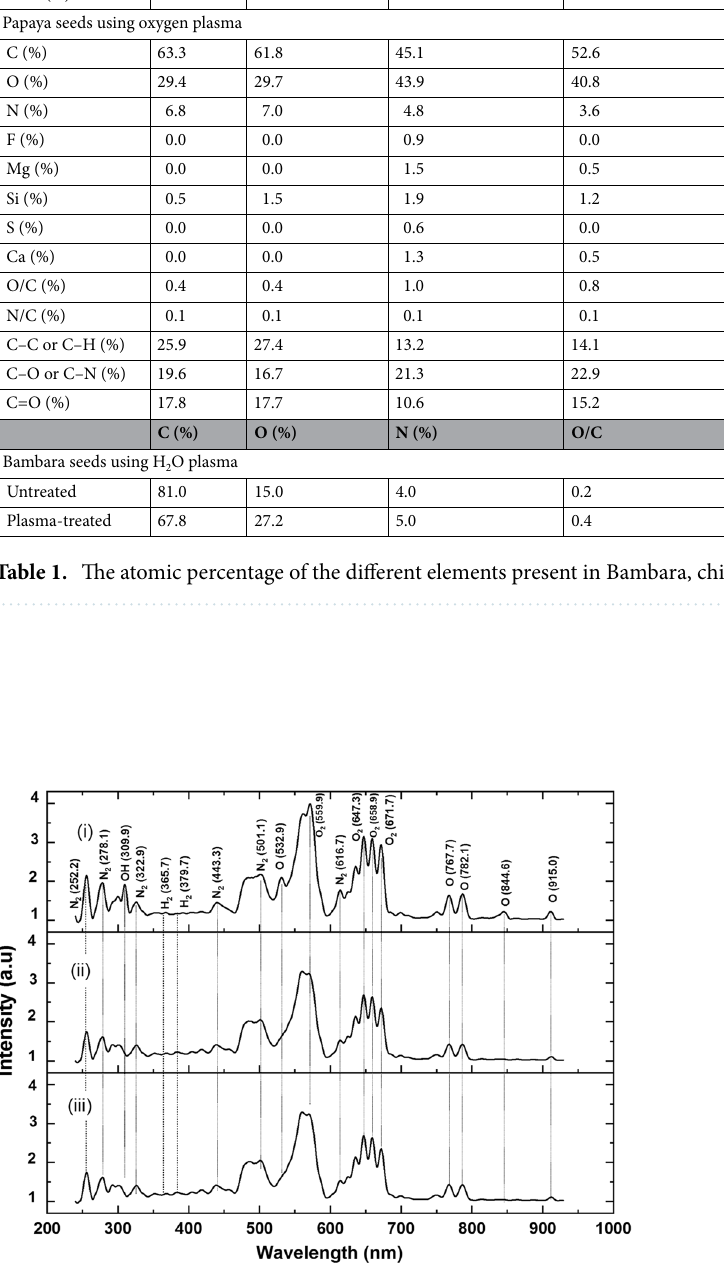
Figure 6. Sub-figure ( i ) represents the spectra obtained during Bambara seeds treatment using water plasma at a discharge power of 10 W for an exposure time of 10 s. Sub-figure ( ii ) represents the spectra obtained during chilli seeds treatment using oxygen plasma at a discharge power of 80 W for an exposure time of 60 s. Sub-figure ( iii ) represents the spectra obtained during papaya seeds treatment using oxygen plasma at a discharge power of 80 W for an exposure time of 40